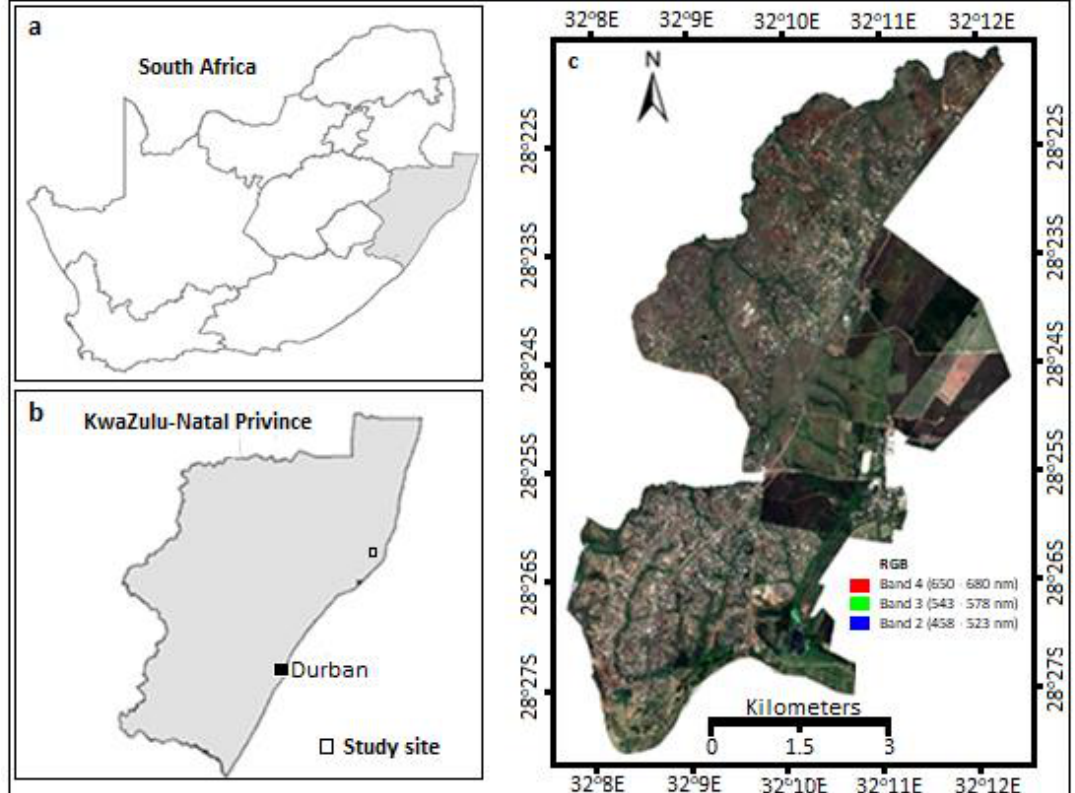
Figure 1. A map of South Africa ( a ) showing the KwaZulu-Natal province ( b ) and the study area ( c ) depicted in a Sentinel-2 true color composite. Table 1. Land use/cover classes and respective